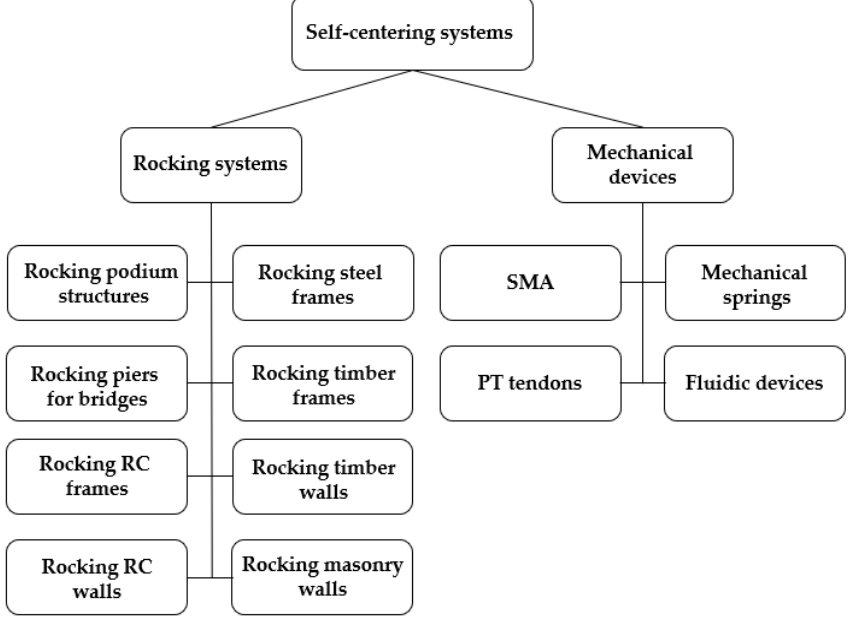
Figure 7. Various self-centering